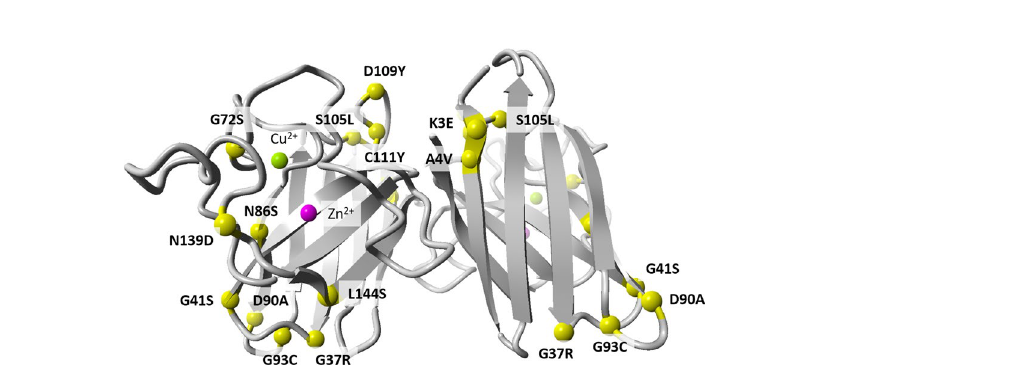
Table 3. Impact of mutations on SOD1 protein. Alternative splicing analysis—probability of altering splicing by mutated allel vs. reference (+ higher; −no changes) (details Supplementary Table S4) HSF Human Splice Finder interperatation, E-S EX-SKIP, BDGP BDGP splice site, Aggregation prediction the tendency for aggregation of mutated allel vs reference (+ higher, − lower) (details Supplementary Table S5, Supplementary File